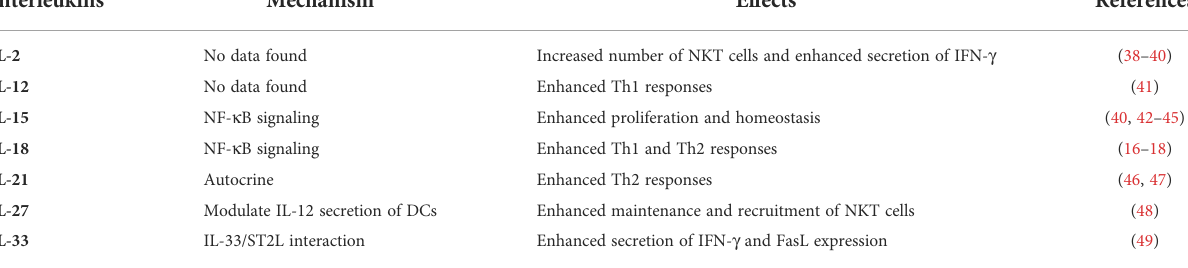
TABLE 1 Reported interleukin-induced NKT cells activation. Interleukins